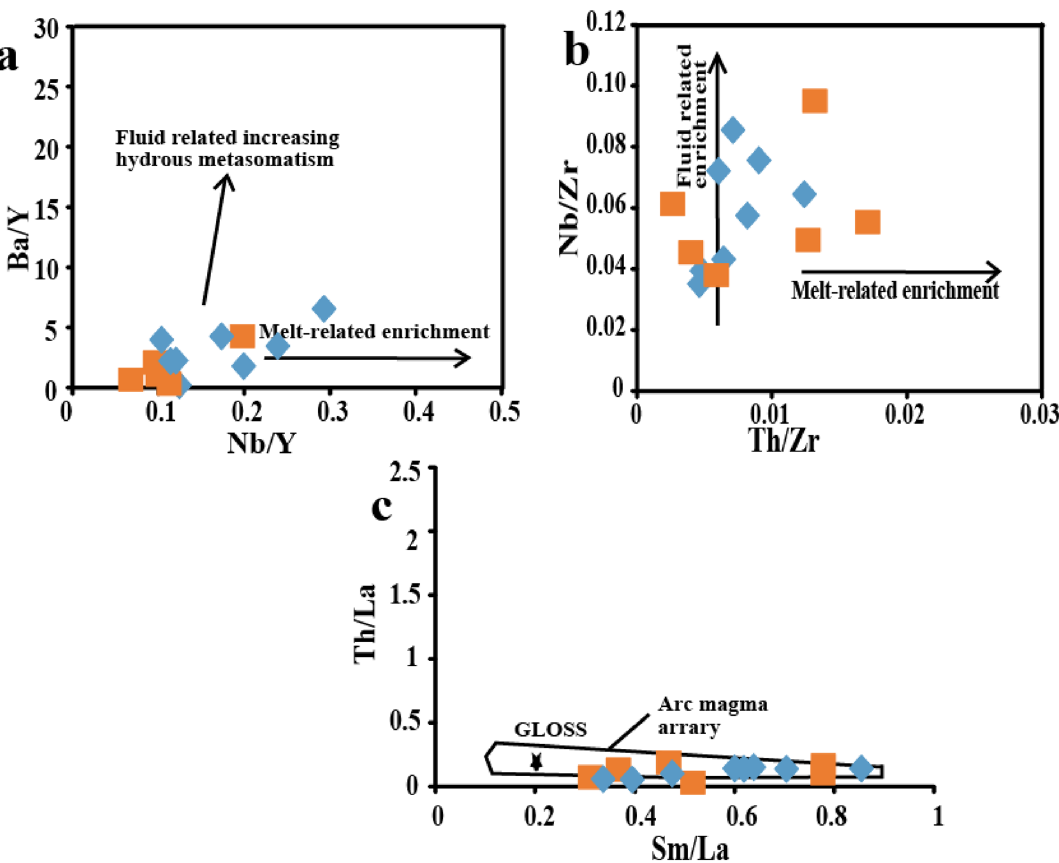
Fig. 14 a Nb/Y vs. Ba/Y (after [85]), b Nb/Zr vs. Th/Zr (after [84]) for the studied meta-mafic rocks, c Sm/La vs. Th/La (after [91, 92]) showing the composition of the meta-mafic rocks. Symbols are the same as in Fig.